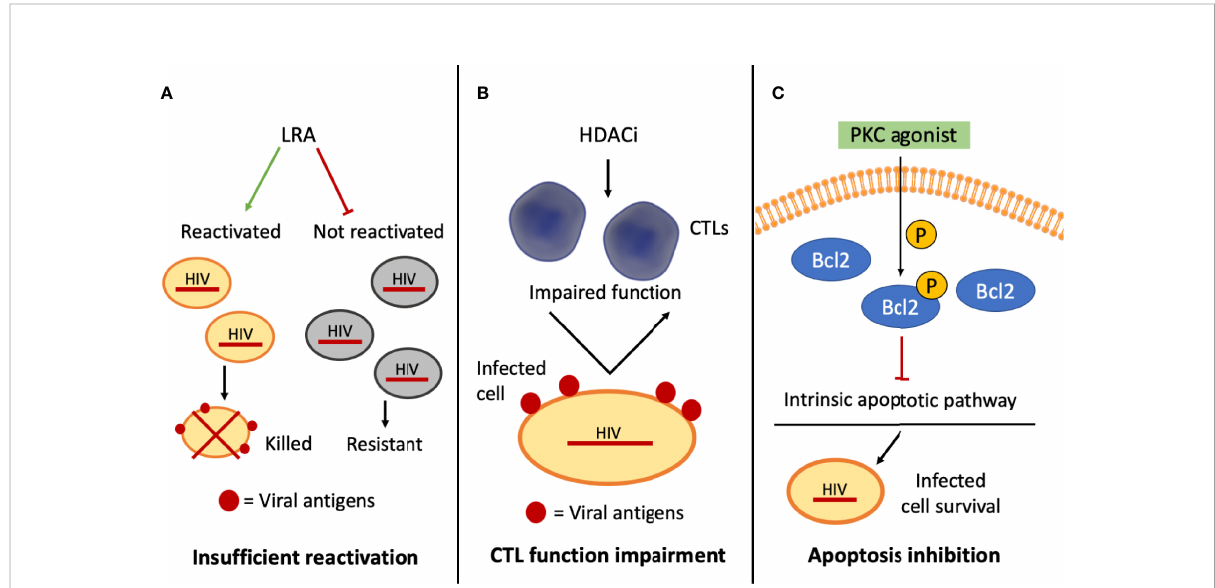
FIGURE 2 Schematic representation of selected mechanisms of HIV-1 resistance to shock and kill approaches. (A) The inability of the latency reversal agents (LRAs) to activate the provirus in all the infected cells interferes with the exposure of viral antigens on this subset of cells (in gray), which cannot be targeted by cytotoxic T lymphocytes (CTLs) – mediated clearance; (B) histone deacetylase inhibitors ( HDACi) may hinder CTL function, affecting CTL-mediated clearance of the infected cells; (C) some PKC agonists can phosphorylate BCL2, blocking the intrinsic apoptotic pathway and promoting the survival of the infected